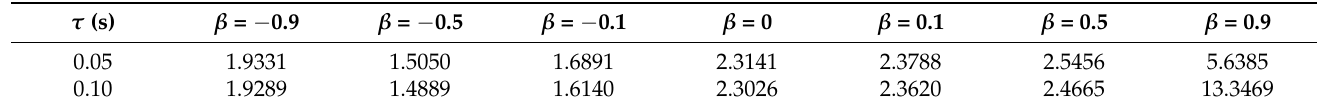
delays and different fractional orders in the proposed controller.